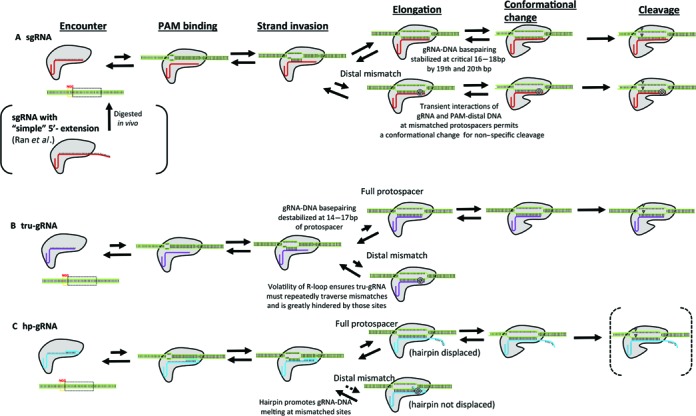
Summary of proposed mechanisms by which the structure of the guide RNA affects Cas9/dCas9 specificity. (A) For the single guide RNA (sgRNA), the first few nucleotides of the RNA (which bind to the 18th–20th positions of the protospacer) stabilize R-loop breathing and binding at the 14th–17th sites of the protospacer, allowing for efficient conformational transitions to the active state in order to permit cleavage. However, this increased stability imparted by these bases allows for transient stabilization at mismatched sites and the conformational change permitting cleavage. In many cases, having traversed a mismatch, R-loops remain stably fully-invaded. (B) For guide RNAs with the first few (here two) nucleotides truncated (tru-gRNA), the reduced stability of the R-loop (characterized by significant volatility) decreases the probability of maintaining the active conformation. When there are mismatched sites in the protospacer, the volatility of the R-loop ensures that it will becomes quickly and repeatedly ‘re-trapped’ behind the mismatch and greatly hindered at those sites. (C) While ‘simple’ extensions of the 5′- end of the guide RNA to target the protospacer and adjoining sites beyond the protospacer was found to be digested back to approximately sgRNA length in vivo (13) (Figure 7A), guide RNAs with 5′- hairpins complementary to ‘PAM-distal’-targeting segments (hp-gRNAs) are anticipated to remain protected within the structure of the Cas9/dCas9 prior to invasion. After binding a PAM site and initiating strand invasion by the hp-gRNA, upon binding to a full protospacer the hairpin is opened and full strand invasion can occur. If there are PAM-distal mismatches at the target site, then it is more energetically favourable for the hairpin to remain closed and strand invasion is hindered. Testing and optimization of the activity of nuclease-active Cas9s with hp-gRNAs in vivo is presently underway.